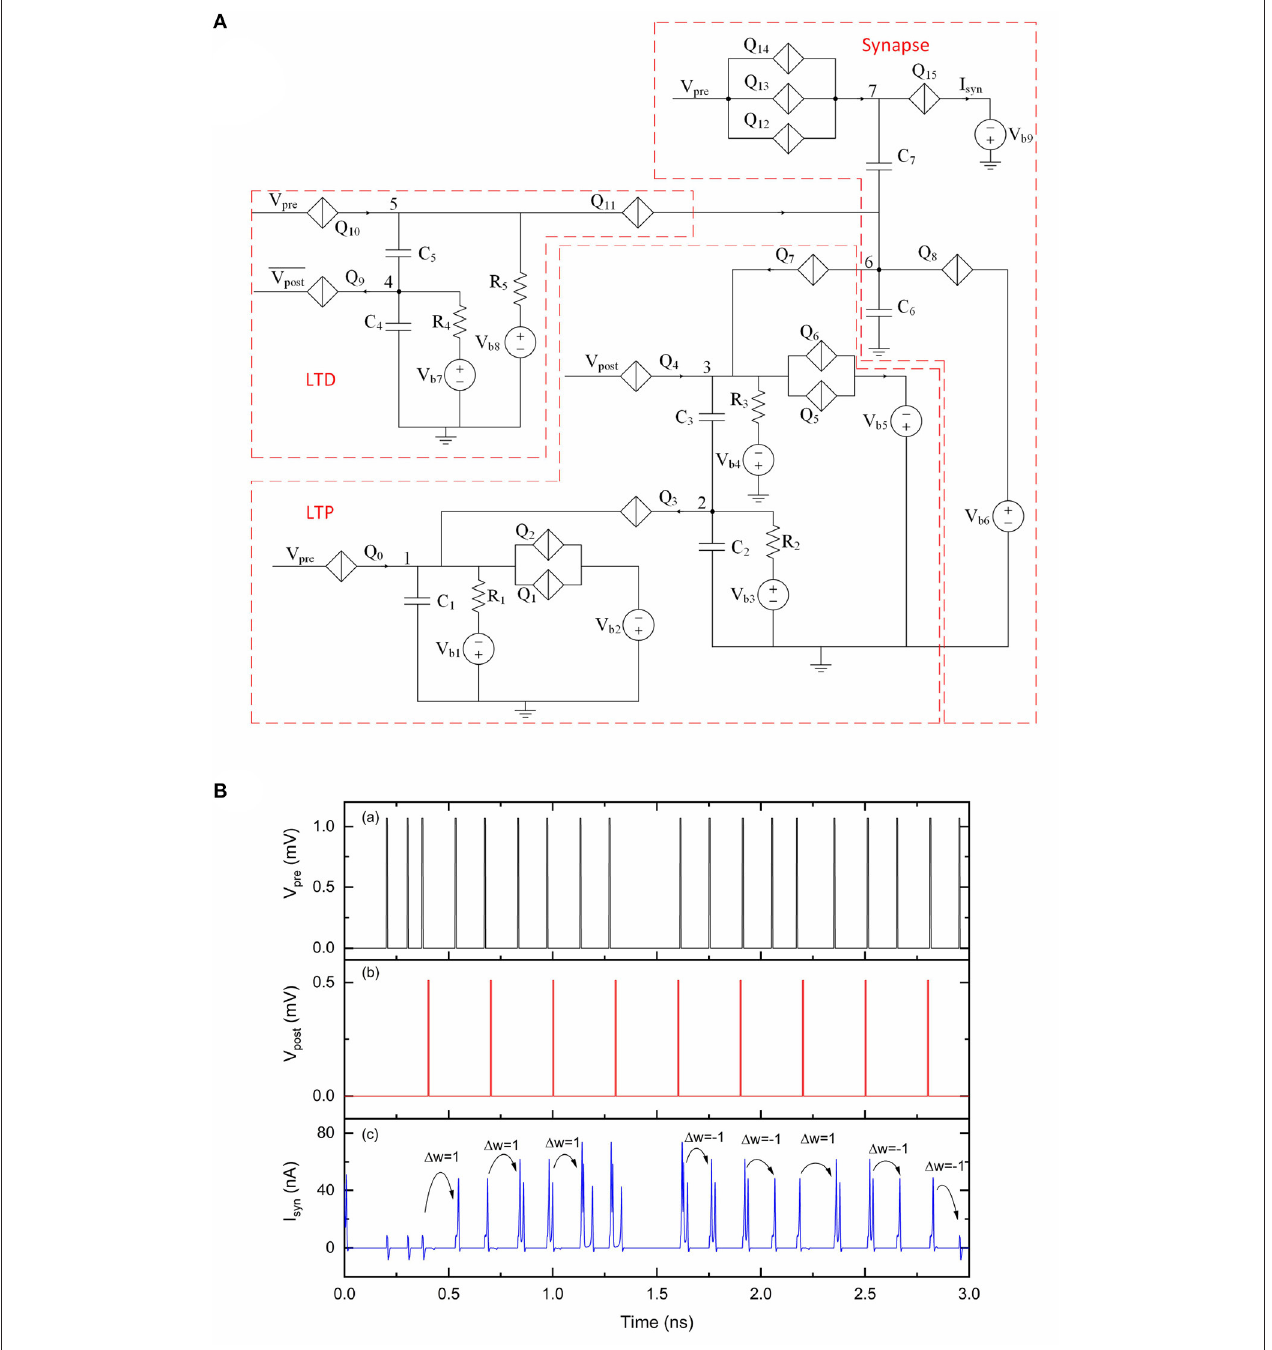
FIGURE 9 | An STDP circuit with a multi-weight synaptic circuit. The number of sequential current pulses at I syn can be updated according to the timings of pulses from V pre and V post . V pre was 1.07 mV. V post was 0.51 mV and V post was 0.51 mV. The critical voltage values used for Q 0 – Q 15 were 0.8, 0.95, 0.95, 0.36, 0.5, 1, 1, 0.46, 2, 0.75, 0.55, 0.3, 1.37, 1.35, 1.33, and 0.28 mV, respectively. C 1 , C 2 , C 3 , C 4 , C 5 , C 6 , and C 7 were 1, 9, 1, 9.2, 1.2, 9.2, and 2 fF, respectively. V b1 , V b2 , V b3 , V b4 , V b5 , V b6 , V b7 , V b8 and V b9 were 0.2, 1.1, 0.05, 0.2, 1.1, 0.89, 0.46, 0.3, and 0.6 mV, respectively. R 1 , R 2 , R 3 , R 4 , and R 5 were 10, 10, 20, 10, and 20 k (cid:127) , respectively. (A) Circuit schematic. (B) Simulation results. (a) Input signal V pre . (b) Input signal V post . (c) Output signal I syn